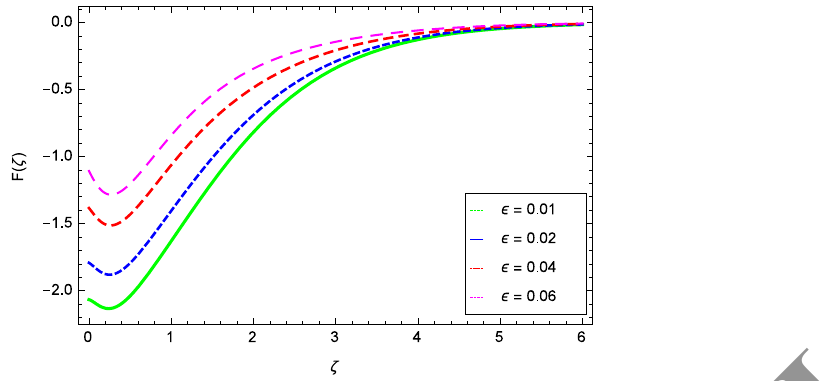
Figure 7. Effect of ǫ on radial velocity F (ζ) .